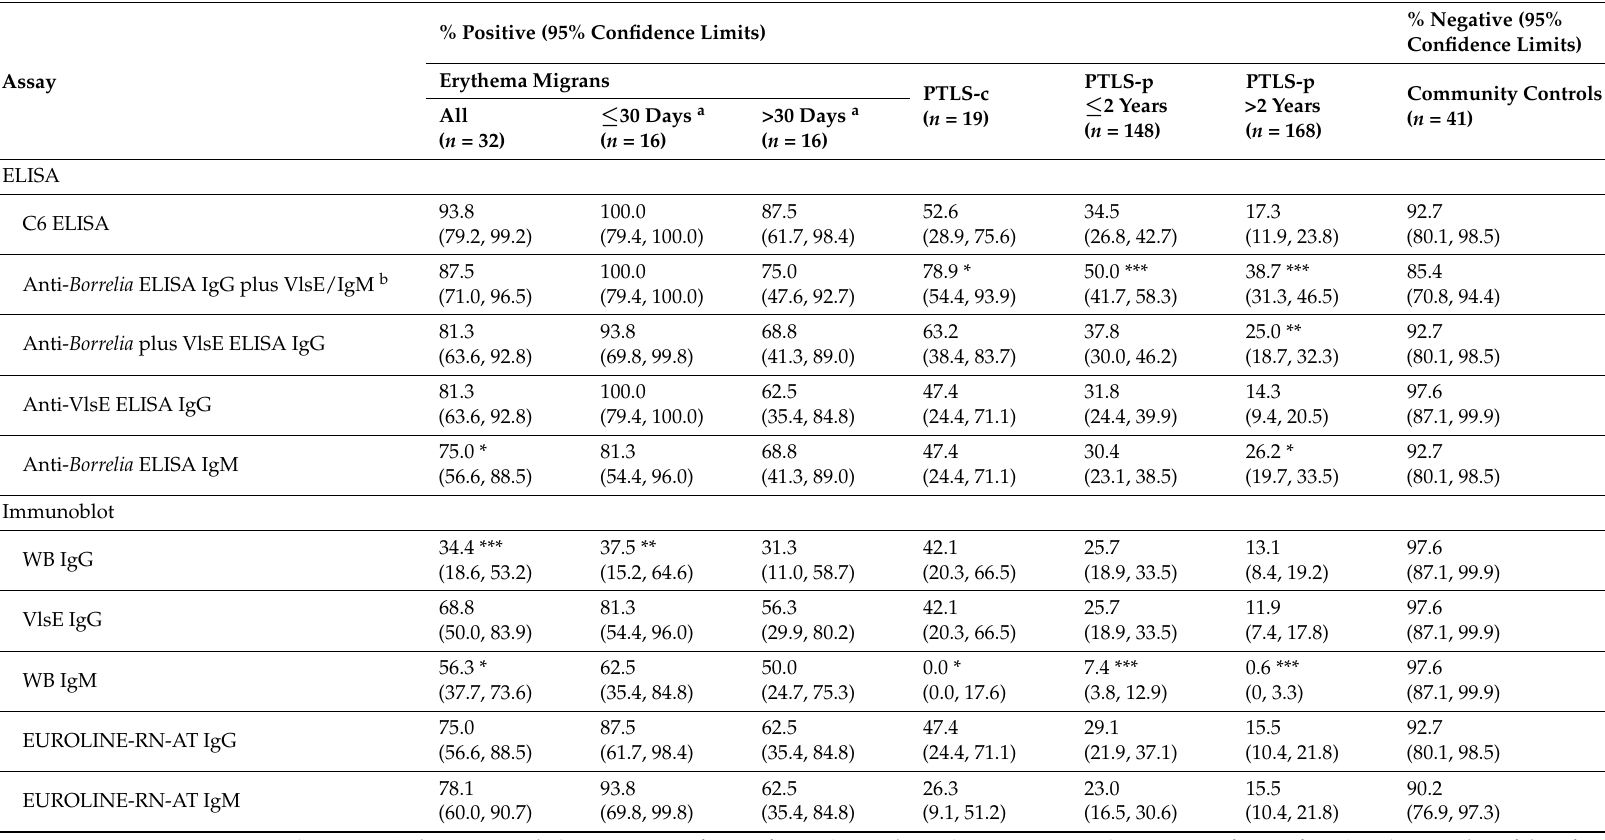
Table 4. Prevalence of anti- Borrelia antibodies by single-tier testing among patients with erythema migrans or post-treatment Lyme symptoms (PTLS).